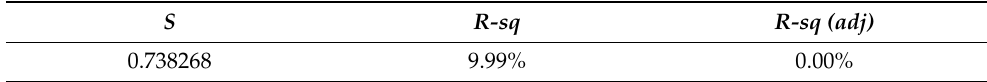
Table 13. Model summary.